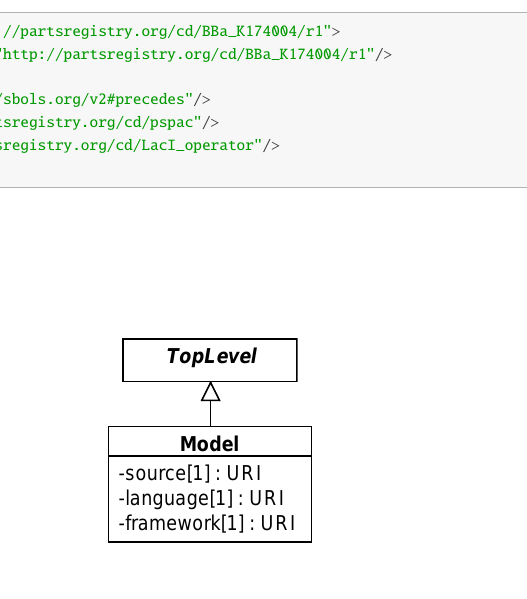
Figure 14: Diagram of the Model class and its associated